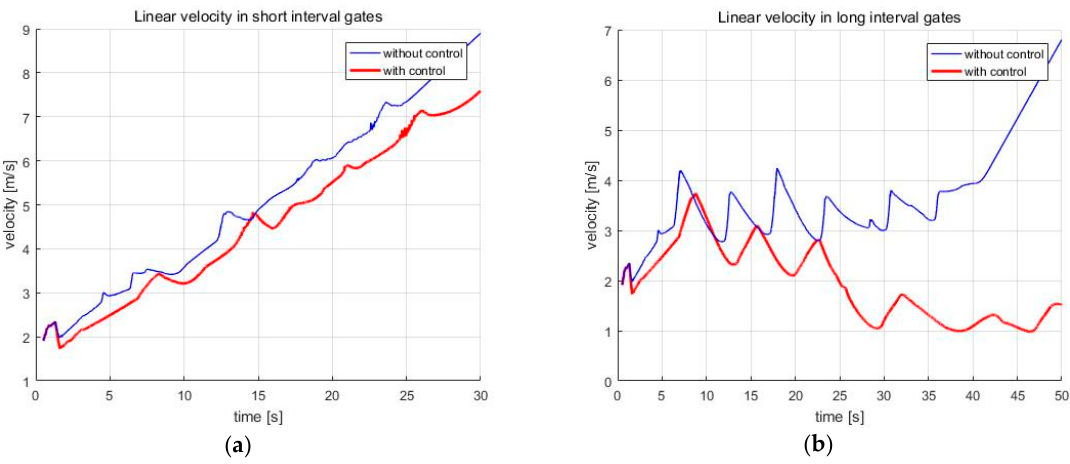
Figure 12. The linear velocity of the skiing robot ( a ) Short interval; ( b ) Long interval.